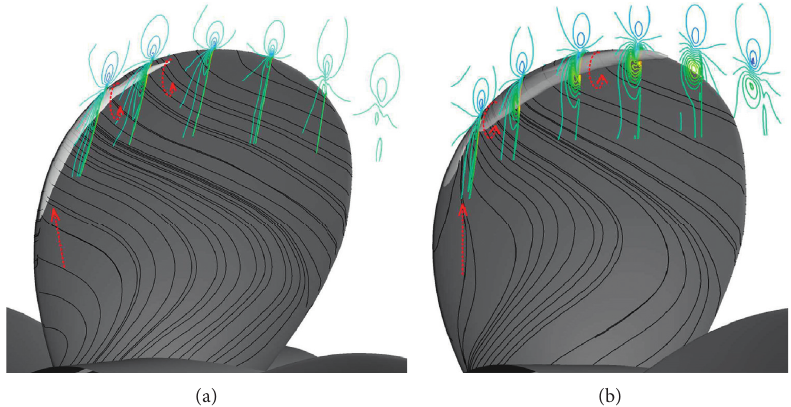
Figure 6: The cavity pattern is shown by an iso-surface of vapor volume fraction α of the flow around the cavitation and blade